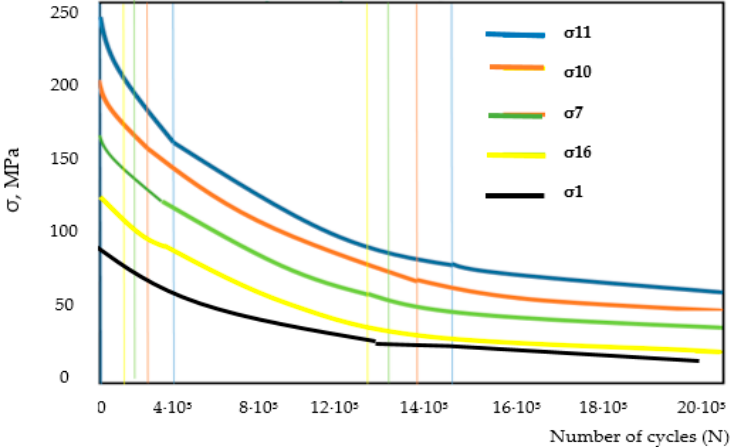
Figure 4. Durability curves of the samples in linear coordinates.